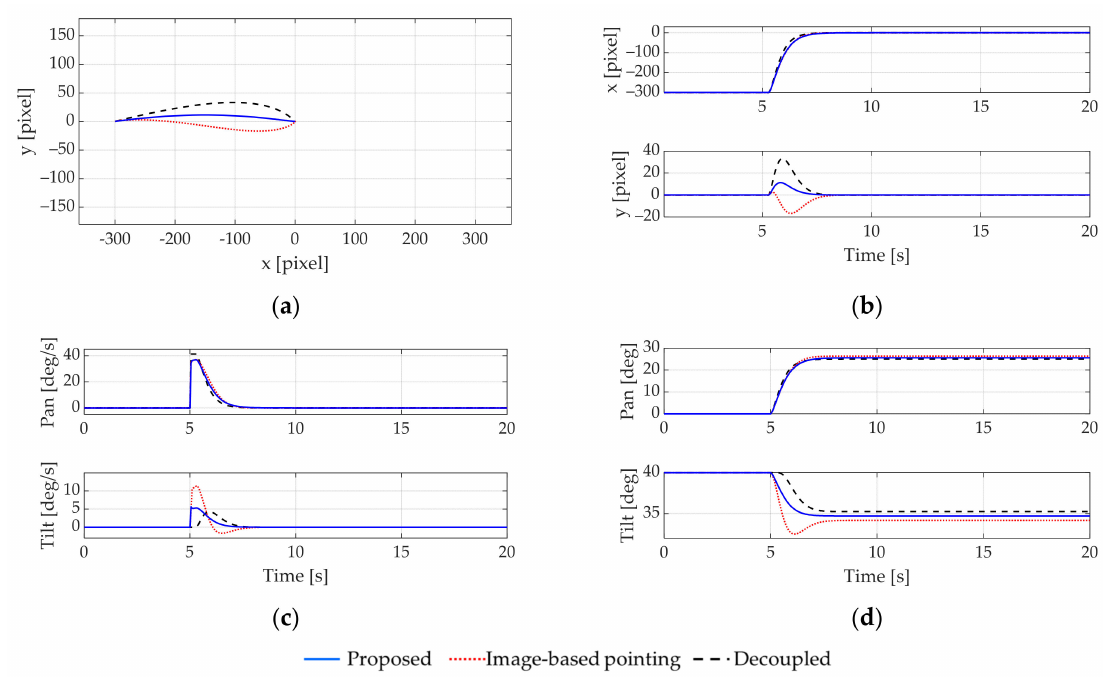
Figure 5. Simulation 1: Tracking a target point on the horizontal line. ( a ) Tracking path on the image plane; ( b ) time response of each coordinate; ( c ) control signals; ( d ) orientations of the inner gimbal.